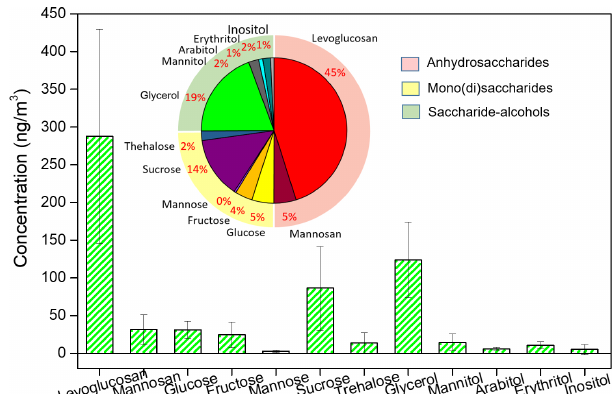
Figure 2. The absolute concentration (bar chart) and the relative contribution (pie chart) of various saccharide compounds during the sampling